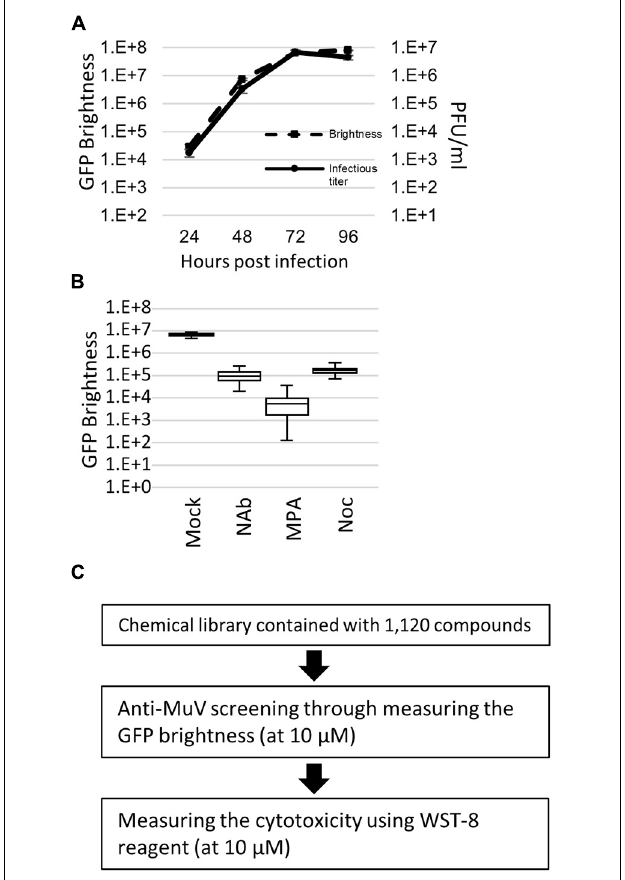
FIGURE 1 | Green fluorescent protein (GFP)-expressing recombinant mumps virus (MuV)-based high-throughput screening. (A) Growth kinetics of the brightness and infectious virus titer. AcGFP-MuV was infected with an multiplicity of infection (MOI) of 0.01 to IFNAR1-KO A549/hSLAM cell. Data were analyzed by plaque assay in triplicate. (B) Validation of Z factor by measuring the GFP brightness of AcGFP Odate infected IFNAR1-KO A549/hSLAM cell at 72 h post-infection. MOI equals 0.01. Inhibitor, 1:20 diluent of neutralizing antibody, 10 µ M of MPA and 10 µ M of Nocodazole, were co-cultured for 3 days. Each assay was repeated 60 times. Vertical axis indicates GFP brightness (Log 10 ). (C) Workflow of the screening in the present study. 1,120 compounds were examined, with 10 µ M of the final concentration in each compound was used at the primary and secondary screening. Each screening was performed